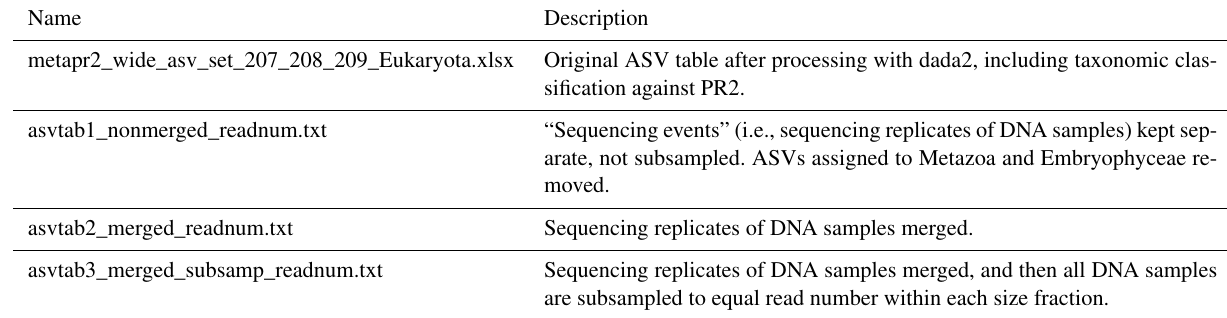
Table 4. Overview of ASV tables. Commands for creating ASV tables 1–3 from the original ASV table are found in the script “asvtables.R”. From ASV tables 1–3, ASVs assigned to division Metazoa or class Embryophyceae have been removed. ASV tables 1–3 are also available as proportions and presence–absence. The original ASV table produced after dada2 processing contains one “sequencing_event” fewer than the number of fastq files deposited in ENA, due to low quality of reads in one of the fastq